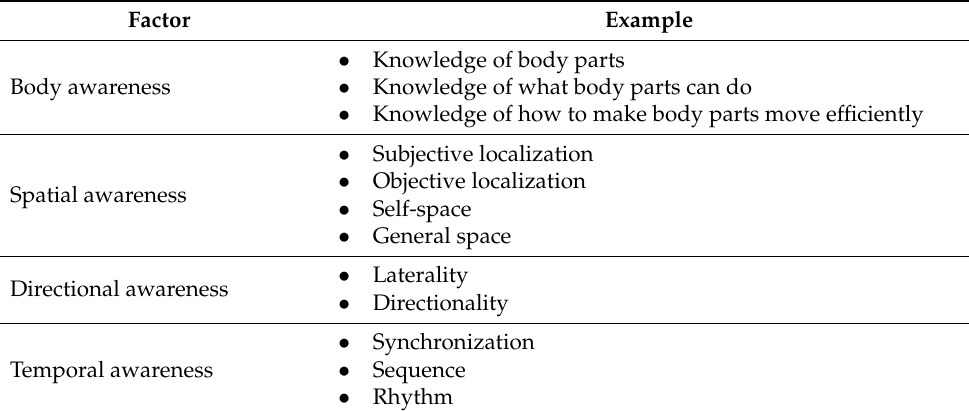
Table adapted from explanation of perceptual-motor components proposed by Goodway, Ozmun, and Gal- lahue